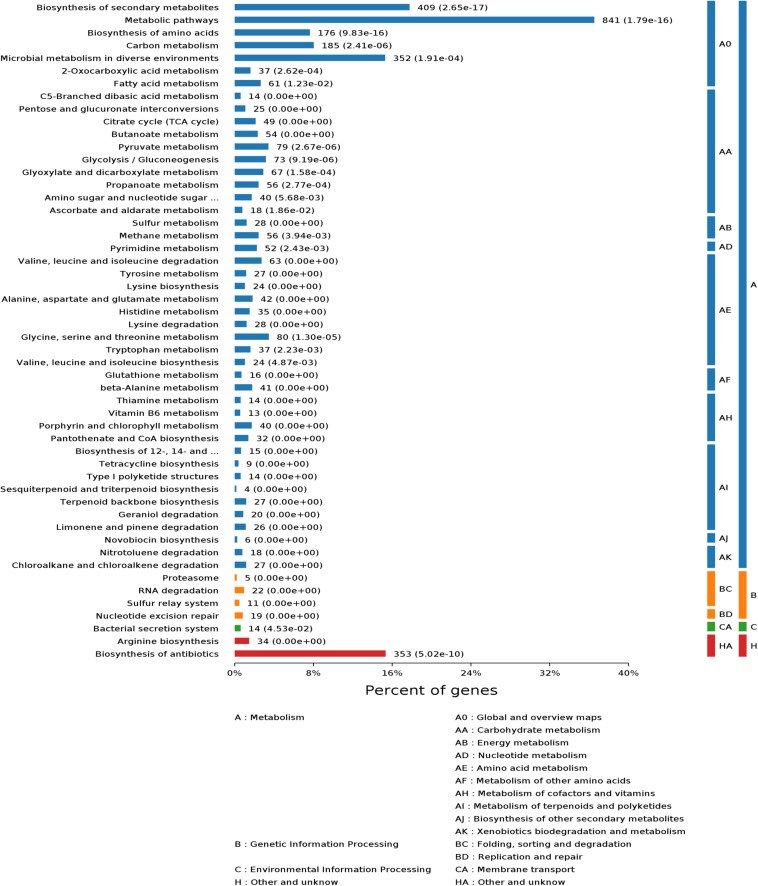
Kyoto encyclopedia of genes and genomes (KEGG) functional classification of the common proteins in S. pogona and S. spinosa. The number of genes associated with each pathway is indicated.